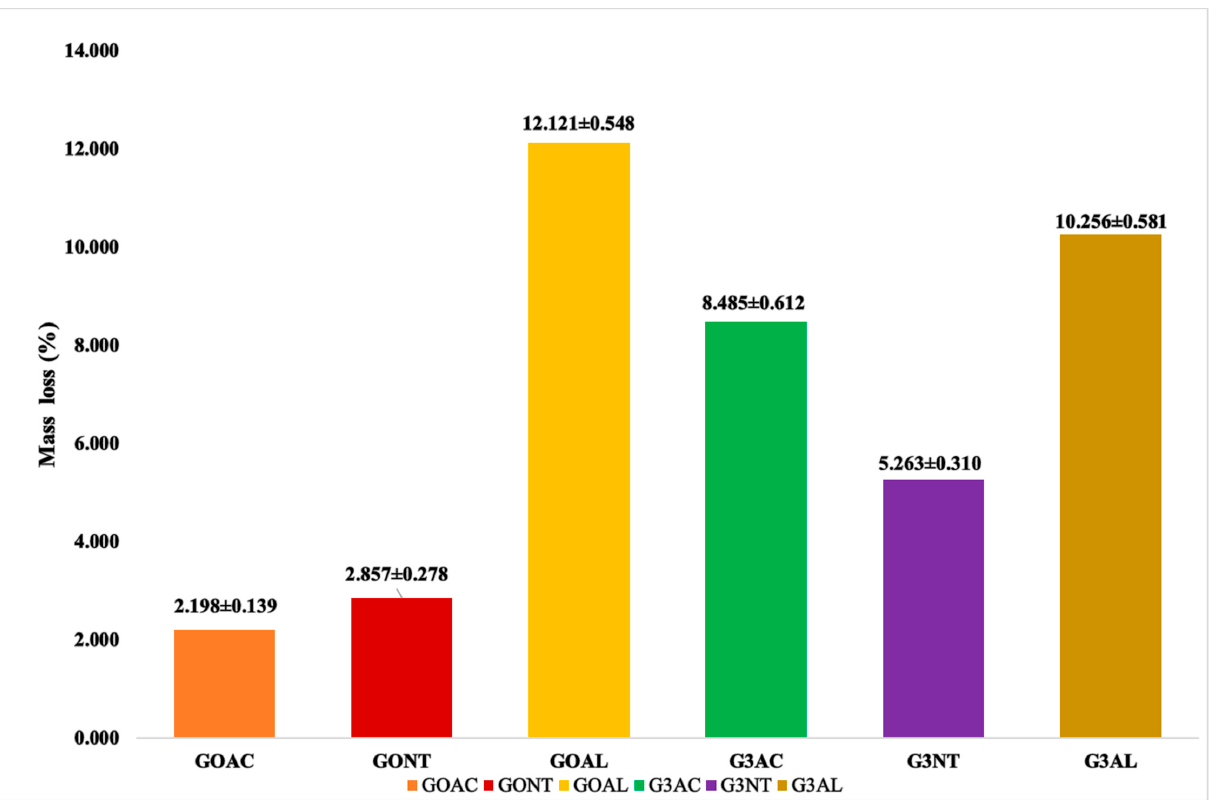
Figure 5. Influence of pH medium on the stability of graphene oxide doped PIM (G3) and control PIM (GO) (where AC = acidic medium, NT = neutral medium, AL = alkaline medium). 3.2. Effect of Amount of Doped GO and Feed pH on the Efficiencies of Ibuprofen Removal The effect of the different amounts of GO added to the doped PIMs (0, 0.15, 0.45, 0.75) compared with the pristine PIM was evaluated using 10 mg/L aqueous Ibuprofen extrac- tion performance. Additionally, the effect of pH of the feed solution was also assessed using the optimal PIM.